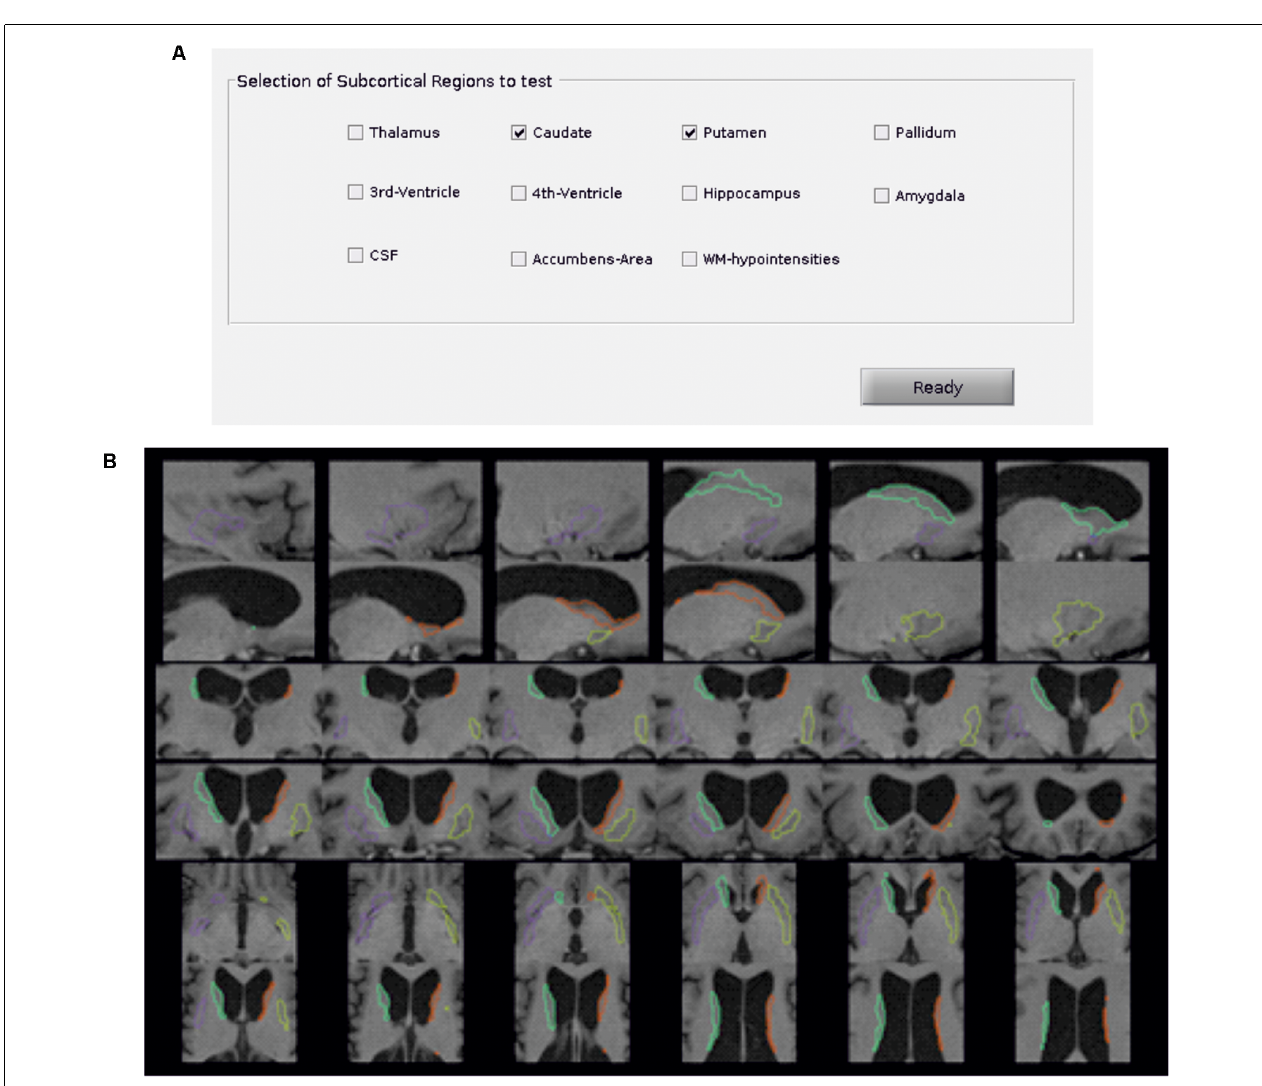
FIGURE 3 | Subcortical parcellation quality control. (A) Selection panel to define the subcortical regions to test. In the example, the caudate and putamen are the selected ROIs. (B) Visualization is generated by the package visualqc to test subcortical parcellation. The resulting parcellation of left (green) and right (orange) caudate and left (purple) and right (yellow) putamen is shown at increasing levels of